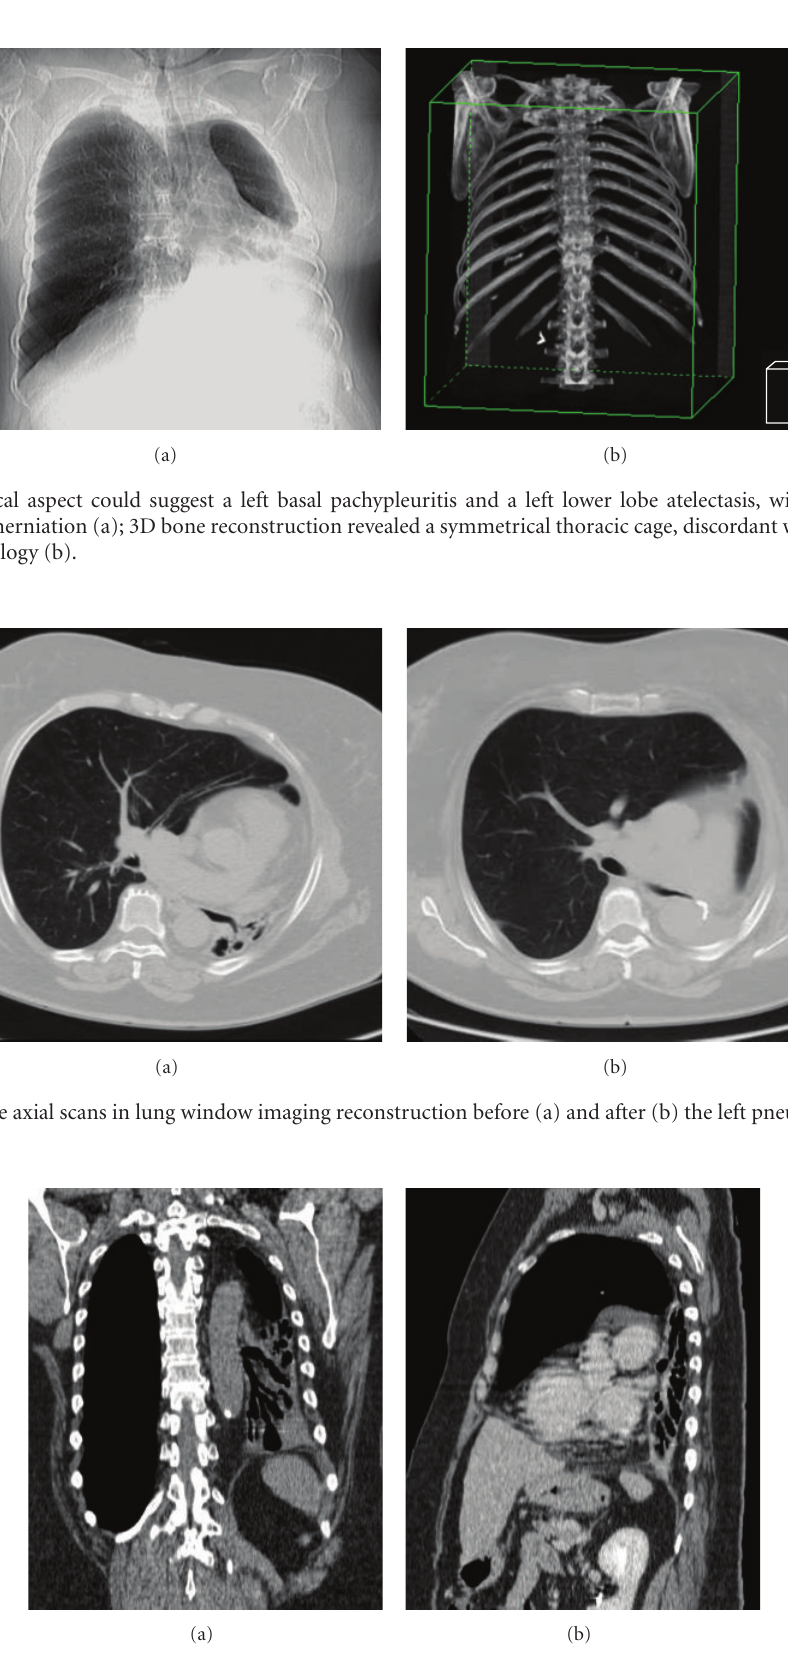
Figure 3: The coronal (a) and sagittal (b) reconstructions in mediastinal window imaging allow a better understanding of the anatomical position of the supra- and underdiaphragmatic